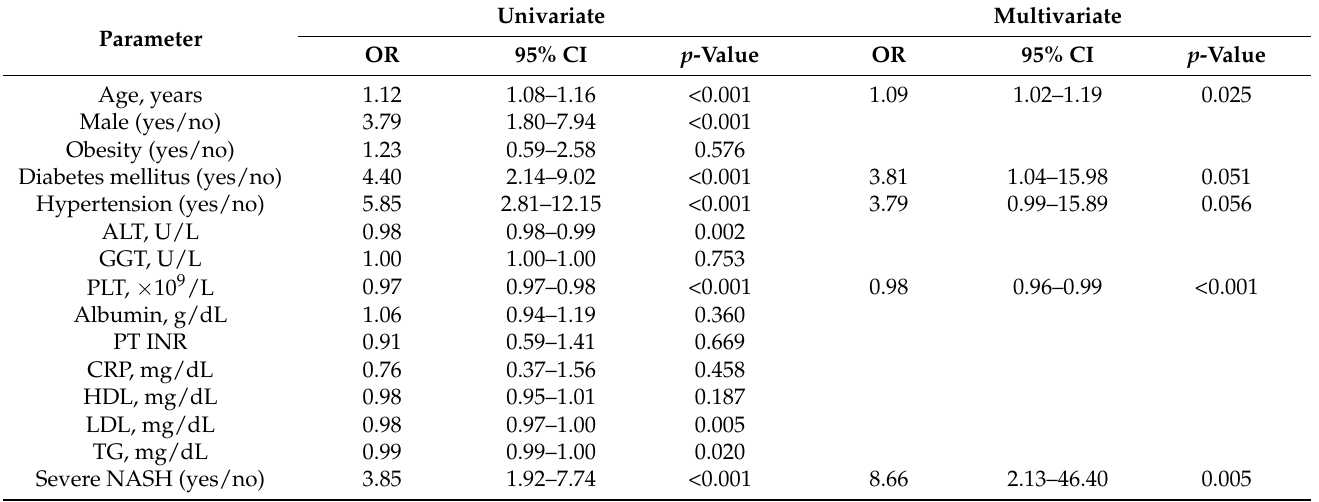
Figure 2. Correlation heatmap of pathologic findings, adipose tissue distribution and skeletal muscle mass. SMI, skeletal muscle index; SATI, subcutaneous adipose tissue index; VATI, visceral adipose tissue index; NAS, NAFLD activity score. Asterisk means p < 0.05. The heatmap data were analyzed using Spearman’s correlation. Table 2. Univariate and multivariate analysis using categorical body composition for advanced liver fibrosis in patients with non-alcoholic fatty liver